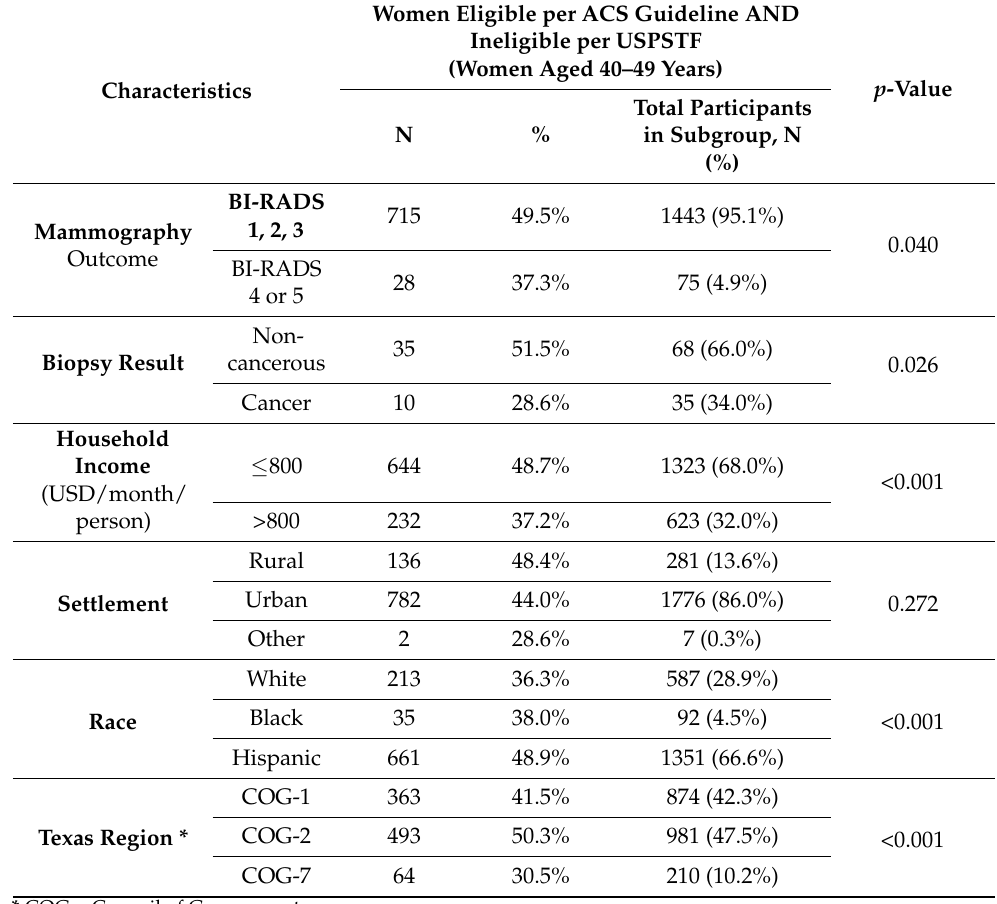
Table 4. Factors associated with mammogram screening, grouped by ages 40–49